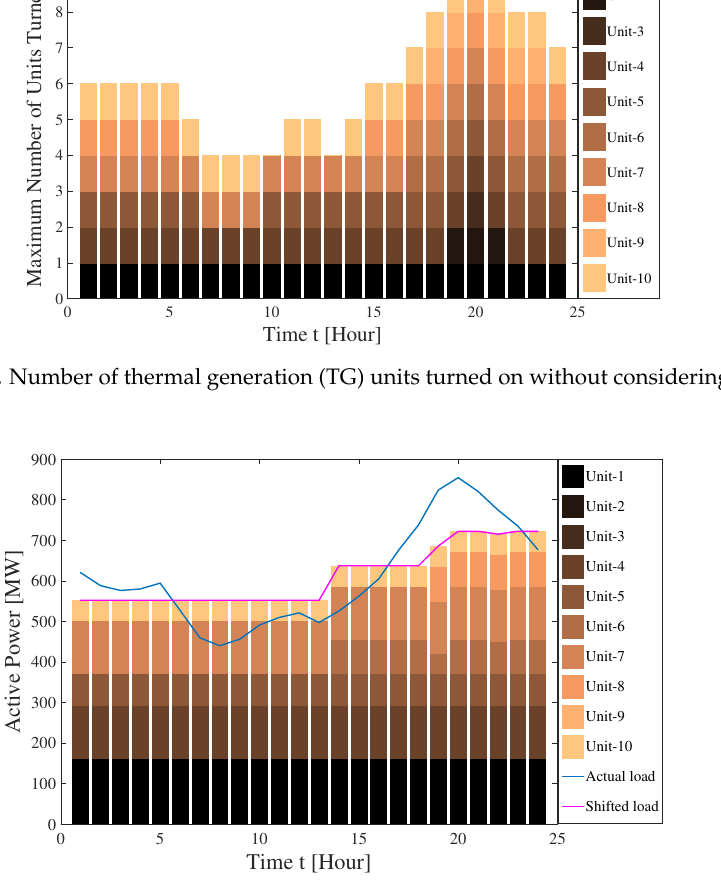
Figure 3. Unit commitment considering